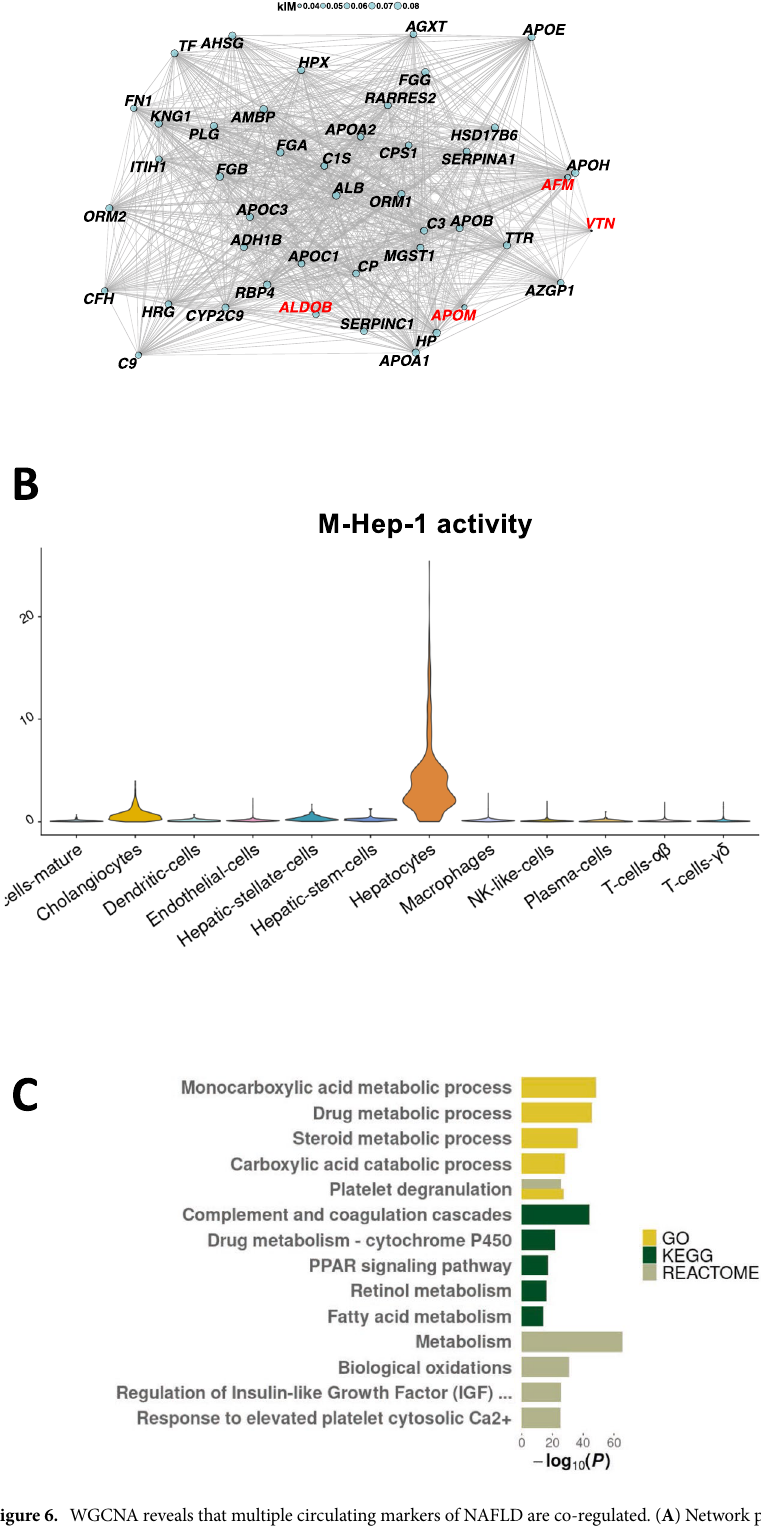
Figure 6. WGCNA reveals that multiple circulating markers of NAFLD are co-regulated. ( A ) Network plot showing the 30 most central genes of M-Hep-8, as well as ALDOB , APOM , VTN , and AFM , four out of six recently identified NAFLD plasma proteome markers. Edge width is proportional to gene–gene co-expression and node size is proportional to gene ‘kIM’ centrality (Methods). ( B ) Violin plot showing the activity of M-Hep-1 in 12 cell clusters. ( C ) The biological function of module M-Hep-1, identified through gene set analysis using the Gene Ontology, Kyoto Encyclopedia of Genes and Genomes and Reactome databases. Up to five of the top hits from each database shown. Only significant results were plotted ( P <